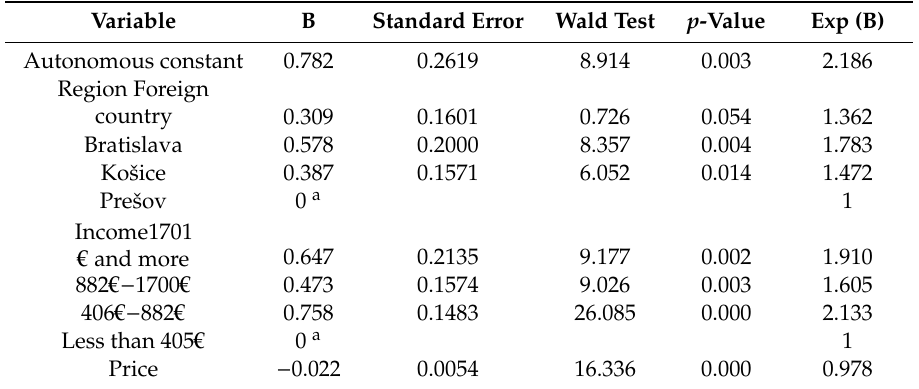
Table 4. The logistic regression output—explanatory variable: Willingness to pay for public goods. Variable B Standard Error Wald